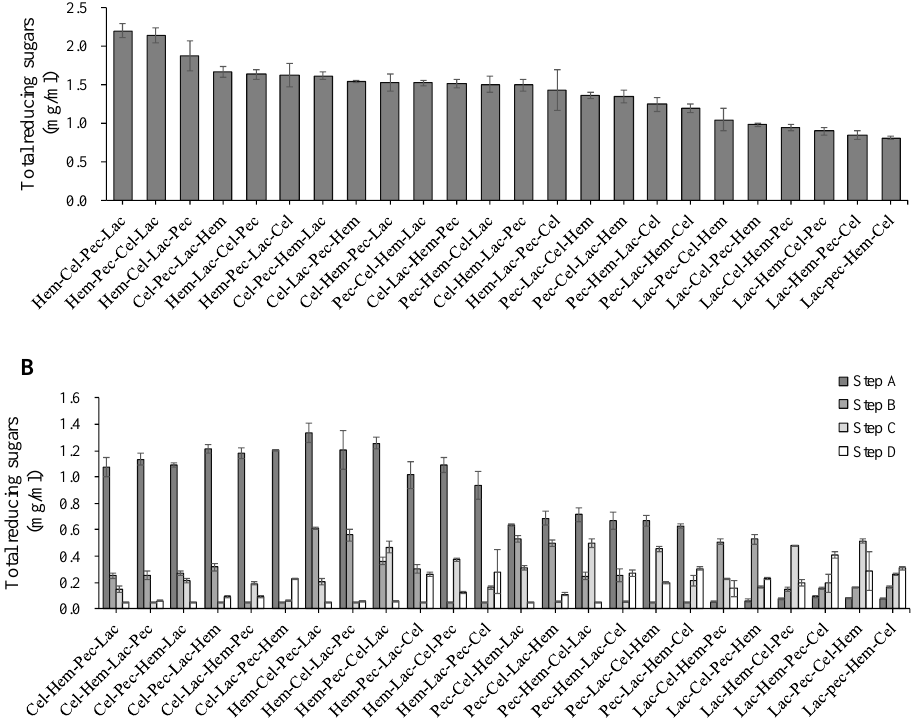
Figure 2. The effect of enzyme sequence action on the release of reducing sugar. ( A ) Total reducing sugar production during four steps enzyme digestion for the corn stover (from the highest to the lowest). ( B ) Reducing sugar production levels during four steps enzyme digestion. The error bars represent standard error of the mean ( n = 3).